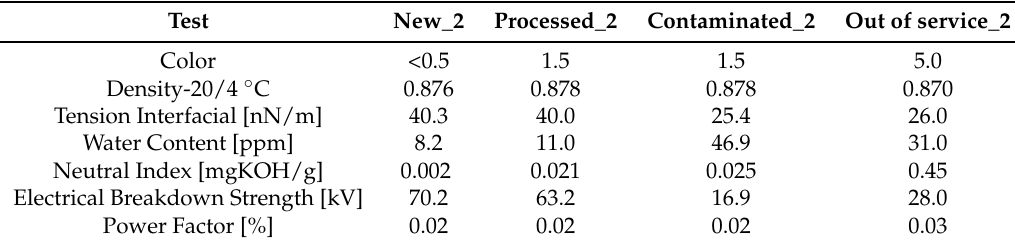
Table 3. Physical-chemical analysis of Database 2.